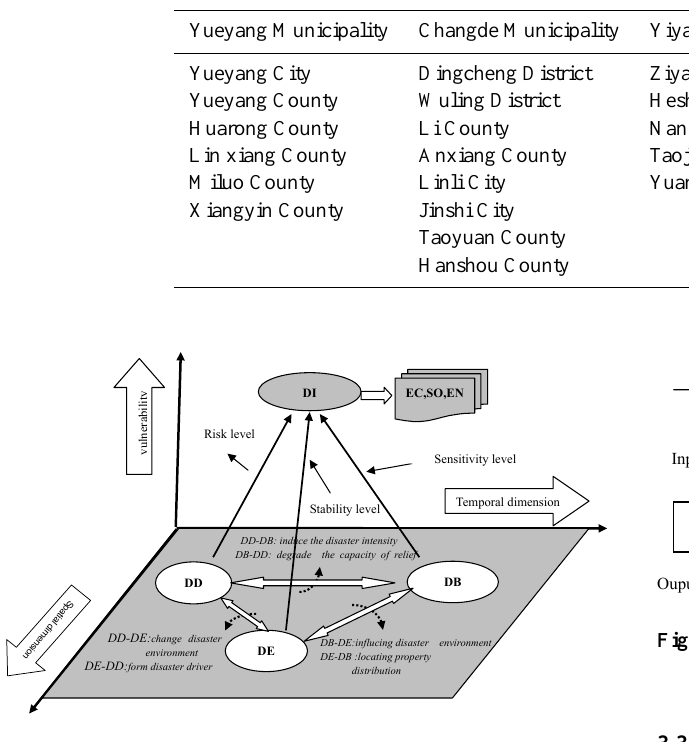
Fig. 2. The flood disaster system and its vulnerability. Fig.2.The flood disaster system and its vulnerability